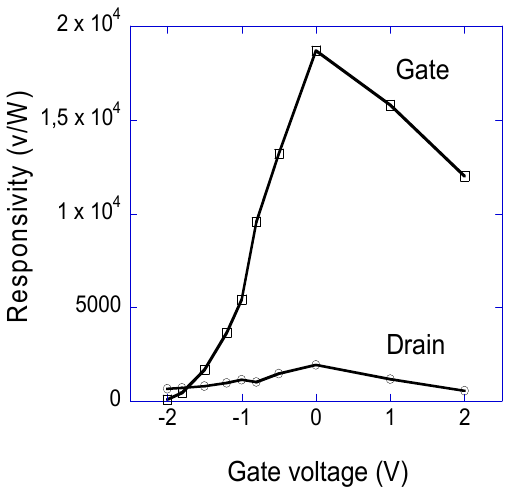
Figure 7. Responsivity calculated by the second harmonic voltage at drain (circles) and the DC voltage at the oxide interface (squares), plotted versus gate bias voltage.